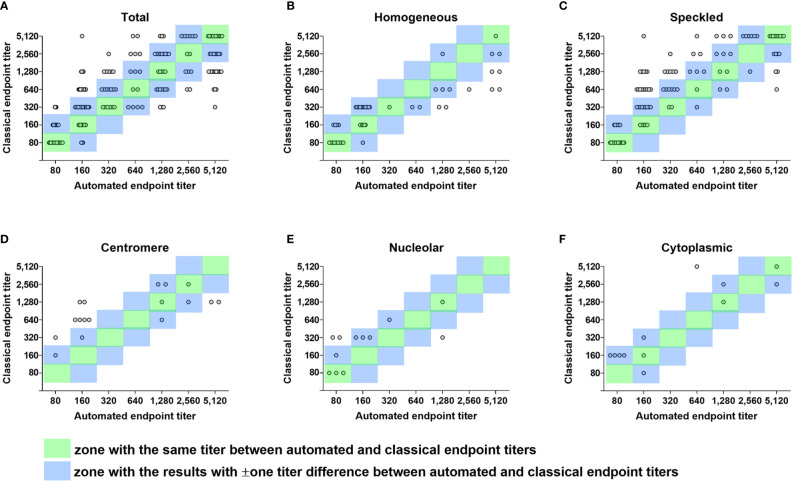
Error grid analysis of concordance between automated and classical endpoint titers. Differences between automated endpoint titer by Helios reading and classical endpoint titer by serial dilution among true positive samples with single pattern referred for ANA titration test only are shown in error grid and scatter plots. (A) A total of 278 true positive samples with single pattern. (B) 51 samples with the same homogeneous pattern by Helios and visual reading. (C) 106 samples with the same speckled pattern by Helios and visual reading. (D) 17 samples with the same centromere pattern by Helios and visual reading. (E) 12 samples with the same nucleolar pattern by Helios and visual reading. (F) 12 samples with the same cytoplasmic pattern by Helios and visual reading. Each circle represents an individual sample. Circles in the green zone indicate samples with the same titer between automated and classical endpoint titers. Circles in the blue zone indicate samples with ± one titer difference between automated and classical endpoint titers. Circles outside the two zones indicate error results with > ± one titer difference. ANA, antinuclear antibody.